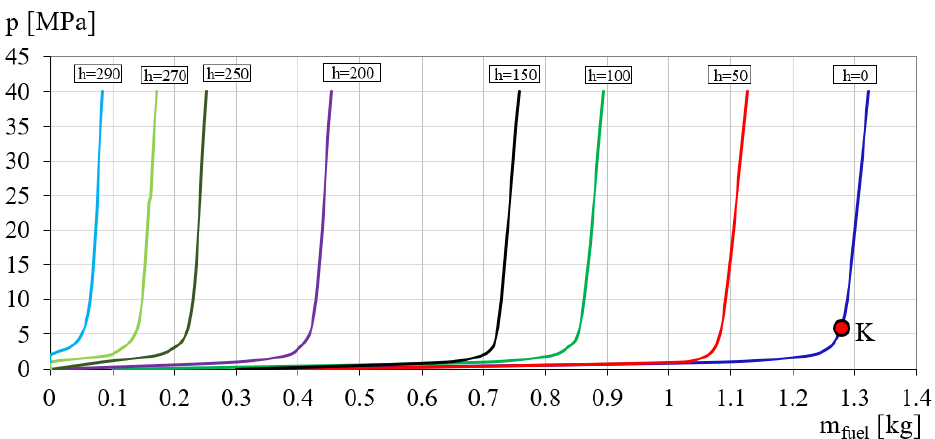
Figure 5. Results of the measurements of the coefficient of solubility of exhaust gas in diesel fuel for the concentration of CO 2 in the fuel of 4% (K—end of exhaust gas dissolution) the concentration of CO 2 in the fuel of 4% (K—end of exhaust gas